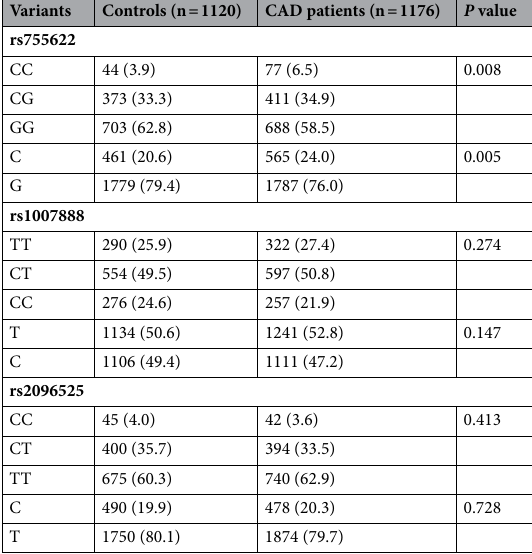
Table 2. Distribution of different genotypes and alleles of MIF gene variation in control and CAD participants. All the genotype frequencies were in Hardy–Weinberg equilibrium ( P > 0.05). The P value of genotype was calculated by Chi-square test. CAD, coronary artery disease.